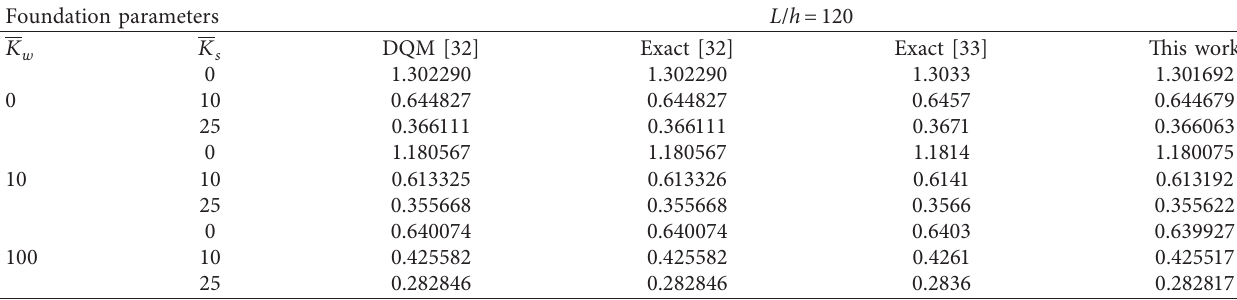
Table 3: Comparative nondimensional maximum deflections w � EI / P on the Winkler–Pasternak two-parameter elastic foundation, S-S.